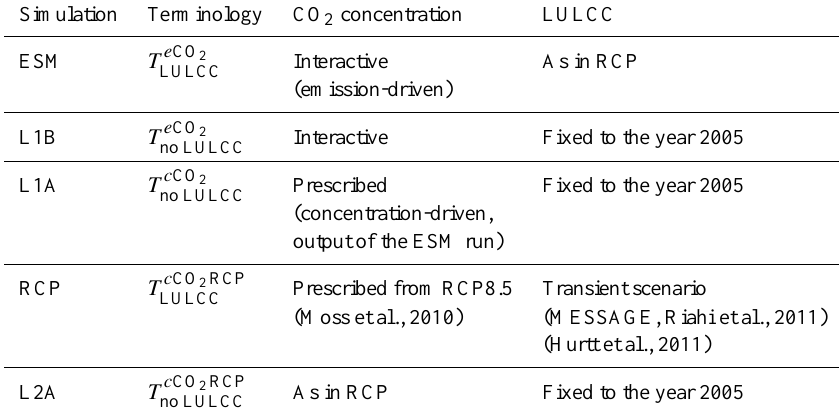
Table 1. Overview of CMIP5 and LUCID simulations based on CMIP5 standard simulations for RCP8.5 and the employed terminology exemplified with near-surface temperature T